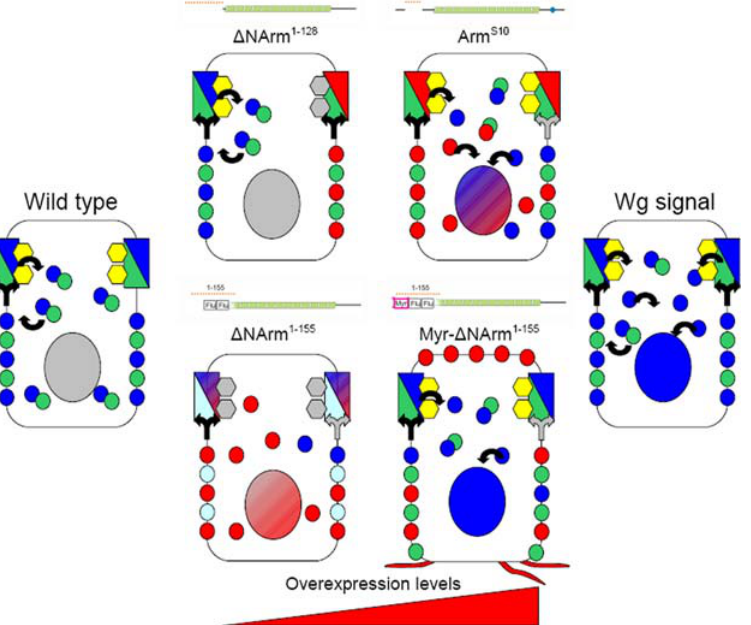
Figure 15. Theoretical model of the localization and interactions of wild type and mutant forms of Armadillo and E-Cadherin. In a wild type cell in its basal state (no signalling, left), Armadillo (blue dots) and E-Cadherin (green dots) are targeted to the membrane, possibly via the exocyst complex [43]. From there, Armadillo/E-Cadherin cycle to the Adherens Junction (AJ, box), or are hypothesised to remain in the cytoplasm as a complex free from degradation. There is little Armadillo in the nucleus (grey oval). During Wingless signalling (right), Armadillo accumulates in subapical puncta and can enter the nucleus (blue oval) to activate Wg targets. We hypothesise that Armadillo/E-Cadherin are released from the AJ (black arrows); alternatively the rate of cycling of Armadillo/E-Cadherin may also be increased. In our proposed model, either in its basal state or during signalling, Armadillo/E-Cadherin may be able to bind a -catenin (yellow hexagon). The activated N-terminal deletion mutants (centre, red boxes and dots) represent a range of effects in the spectrum between the basal state and Wingless signalling, depending at least in part on overexpression levels (bottom, red bar). D NArm 1–128 (centre, top left) most closely resembles the basal state, with little Armadillo in the nucleus or signalling. At highest levels of overexpression, D NArm 1–128 excludes Armadillo from the basolateral membrane and AJ, and is unlikely to efficiently bind a -catenin (grey hexagon; [76]). Arm S10 (centre, top right) excludes Armadillo from the AJ, as well as basolateral membranes at lowest expression levels. However, Arm S10 has no effect on E-Cadherin levels and should have the capacity to bind a -catenin [30,76], thus ensuring appropriate adhesive function, as well as signalling (red and blue nucleus). In this case, we propose that Armadillo/E-Cadherin at the basolateral membrane may not be sufficiently stable to enter the AJ (grey arrow). Several sources indicate that Armadillo/E-Cadherin is first targeted to the basolateral membrane, and from there to the AJ [42,78]. Myr- D NArm 1–155 , while unable to bind a -catenin [76], nevertheless ensures adhesive function through Armadillo/E- Cadherin at the AJ. These would be able to efficiently cycle between the subcellular compartments and enter the nucleus (blue oval). Additionally, filopodia extend into the environment from the basal side of cells expressing Myr- D NArm 1–155 . D NArm 1–155 , in contrast, impedes proper Armadillo/E- Cadherin function at the basolateral membrane and AJ through a reduction in their levels (fewer blue dots, pale green). It is unable to bind a -catenin, but enters the nucleus where it may interact with the transcriptional machinery. Note that all representations of cytoplasmic protein localisation are inferred from changes in the other more easily quantifiable compartments (e.g. ‘‘cellular’’=nucleus + basolateral membrane +